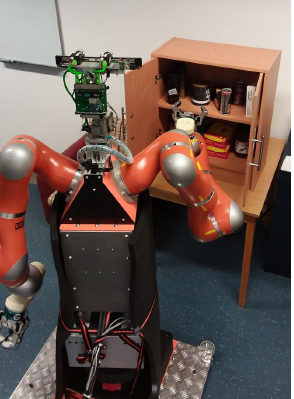
Figure 7. Velma robot operating in the